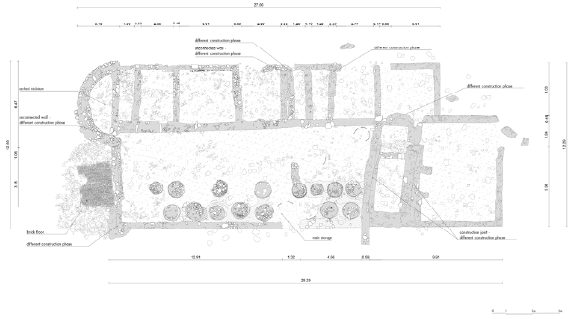
Figure 2. The typology of the sunken roman villa (2D drawing).